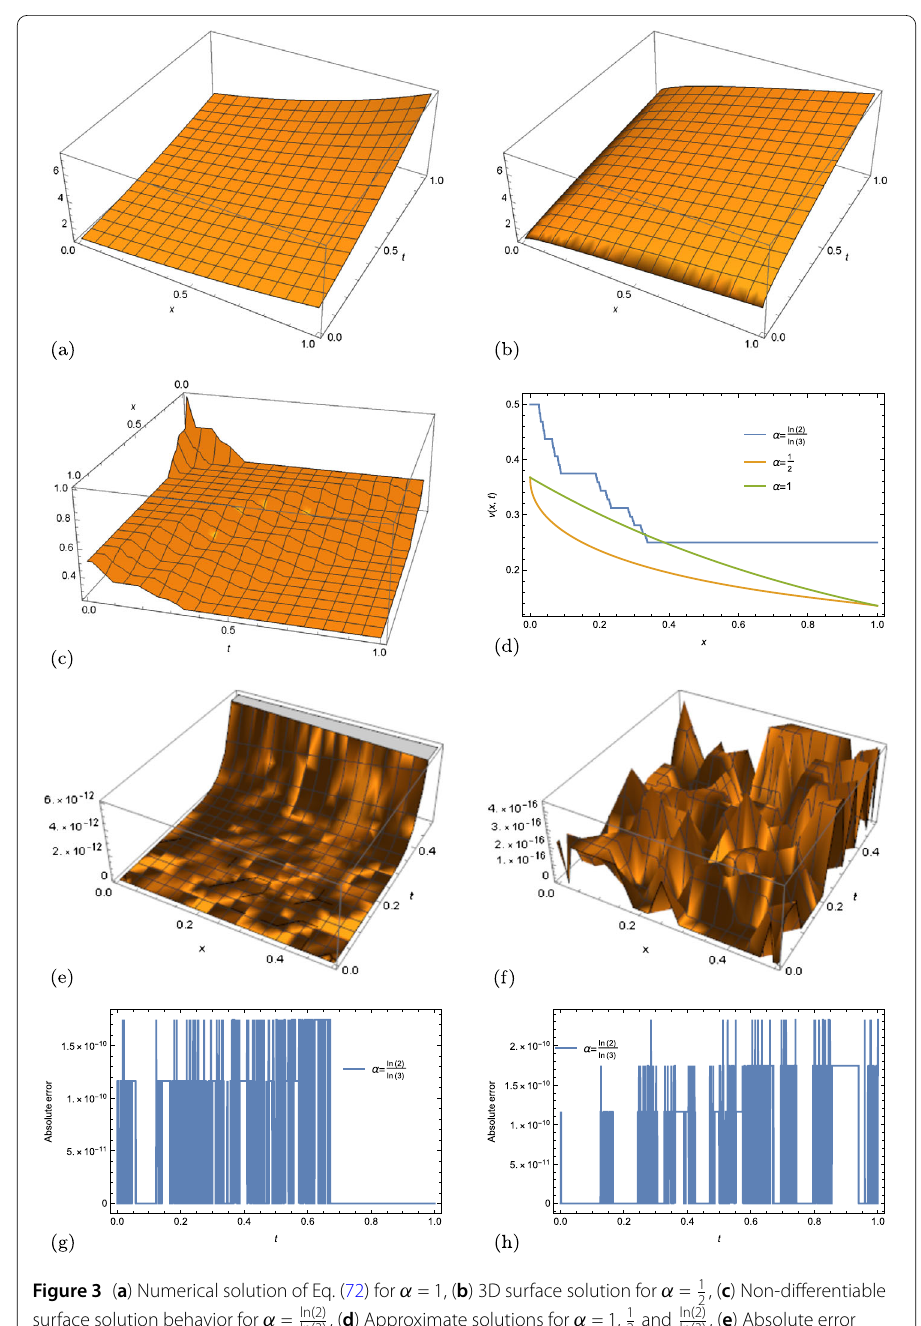
, ( d ) Approximate solutions for α = 1, 1 ln(3)